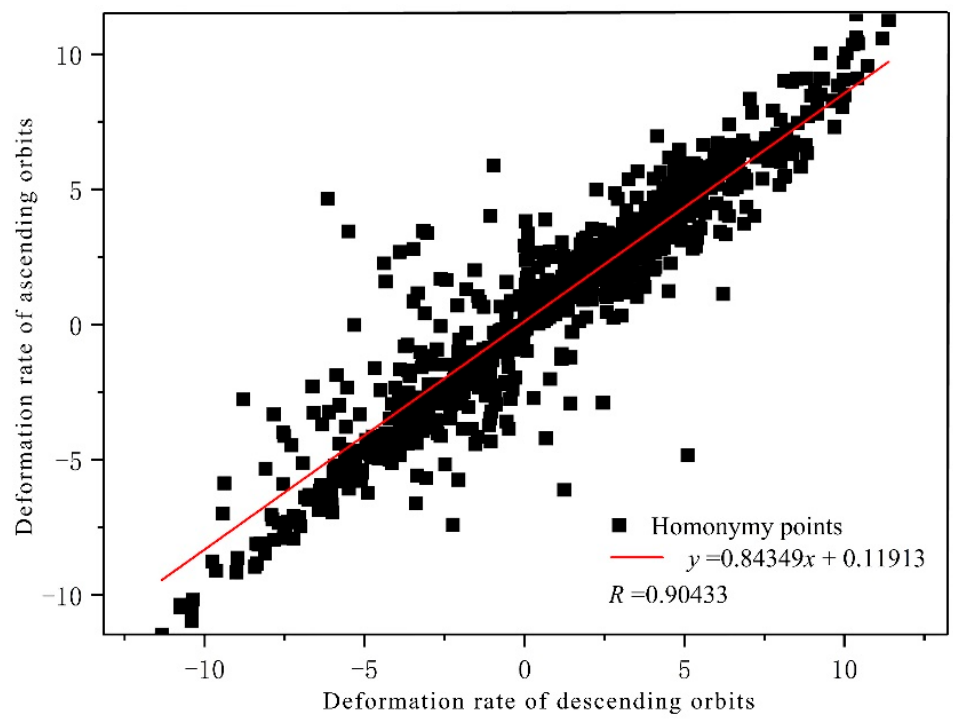
Figure 7. Correlation coefficient diagram of annual average deformation rate of ascending and descending